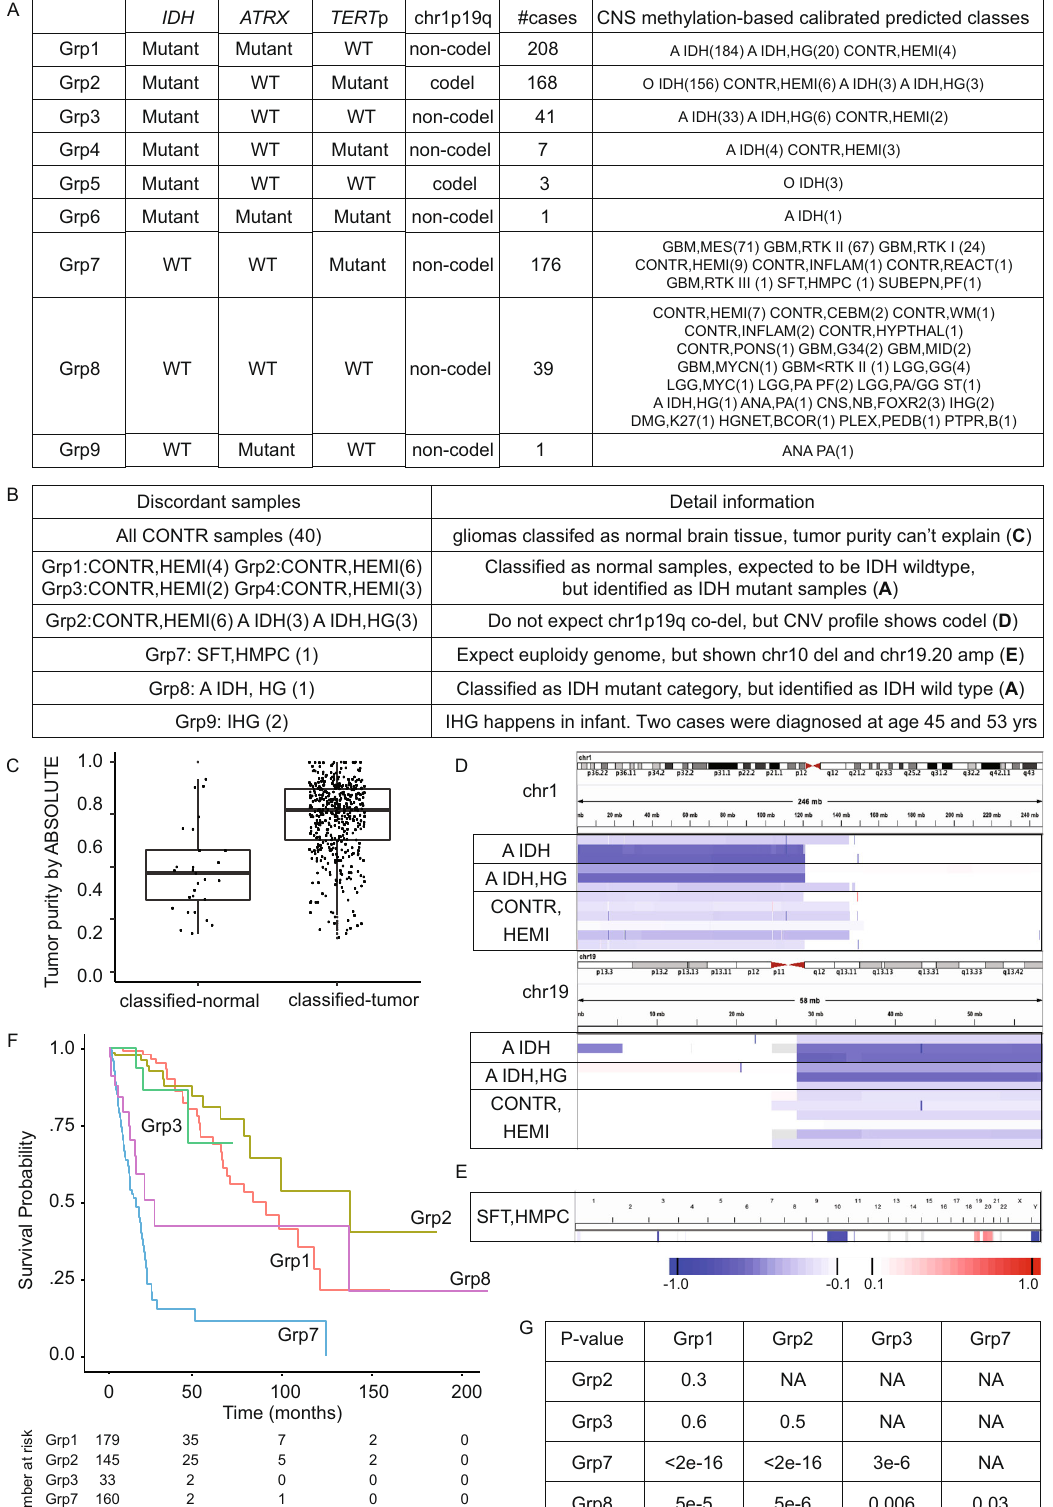
The fi nal model was determined based on performance in the development set; the number of probes used in the fi nal models were 100, 1000, 500 and 100 for IDH mutation prediction, TERT p mutation prediction, ATRX mutation prediction and 1p/ 19q co-deletion prediction, respectively. The fi nal alpha and lambda values were: for IDH mutation, TERT p mutation and ATRX mutation prediction, alpha = 0, lambda = 1; for 1p/19q co-deletion prediction, alpha = 0, lambda = 0.1. Performance of the models with varying parameter values are shown in Supplementary Figs. 5 – 8.